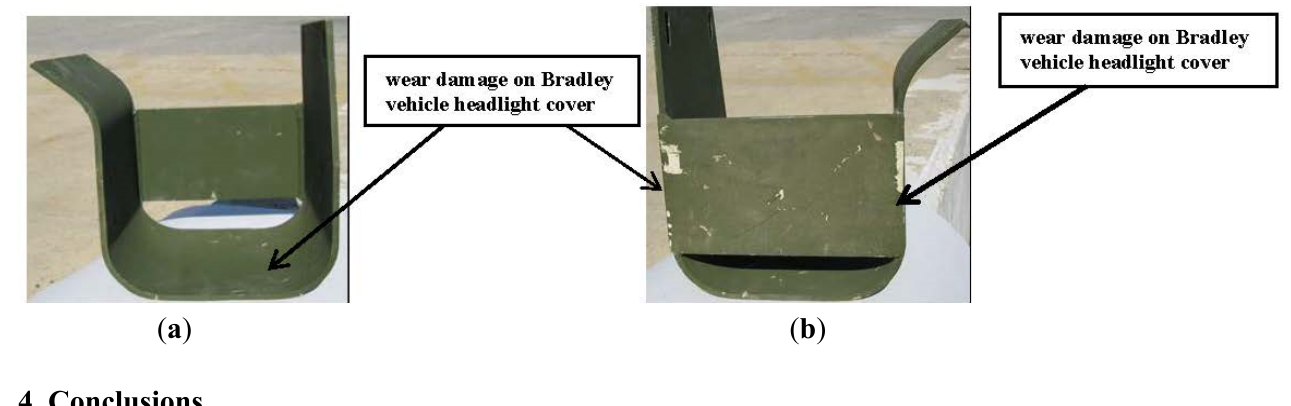
Figure 7. Wear damage after one-year of field testing the headlight cover: ( a ) wear damage front view; and ( b ) wear damage backside